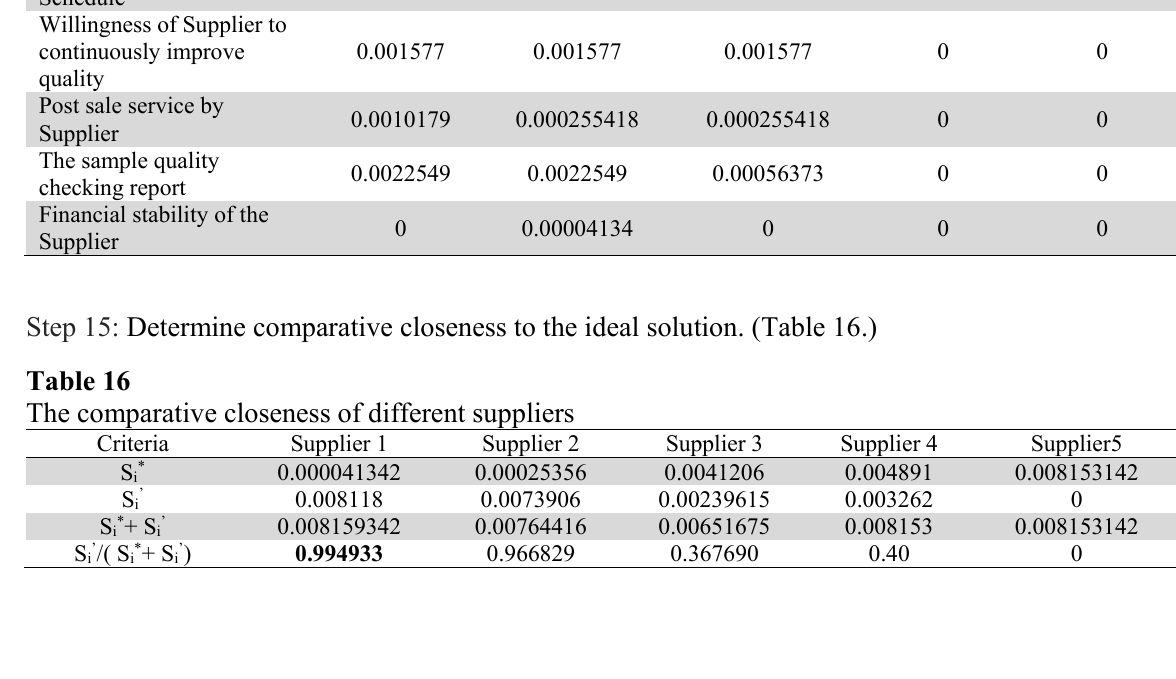
Separation from the Negative ideal solution Criteria